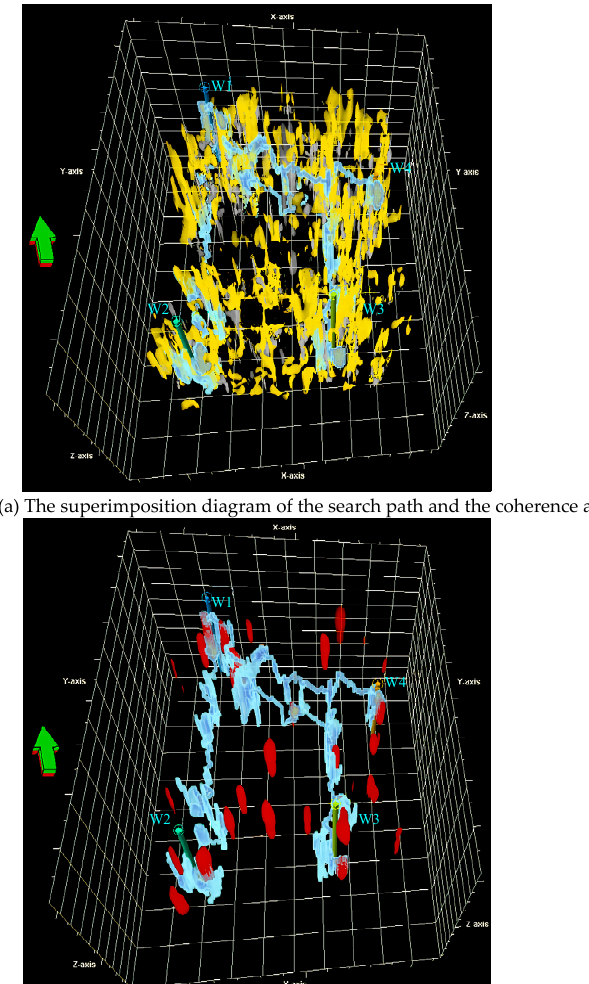
Figure 6. The Karst-Fracture Characteristics of A well group.